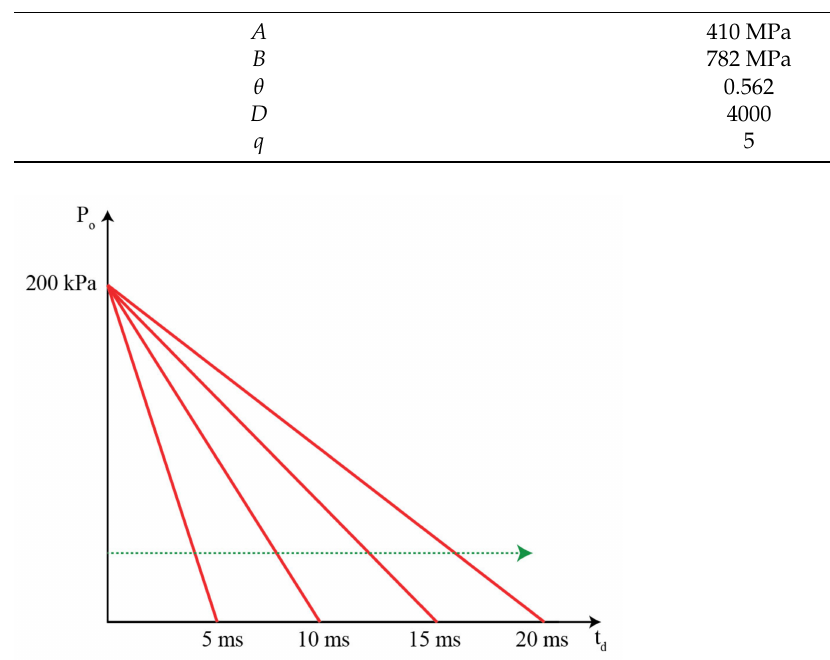
Figure 11. Combinations of maximum blast pressure and positive phase duration (pressure- controlled scenarios) applied to the cladding of the case